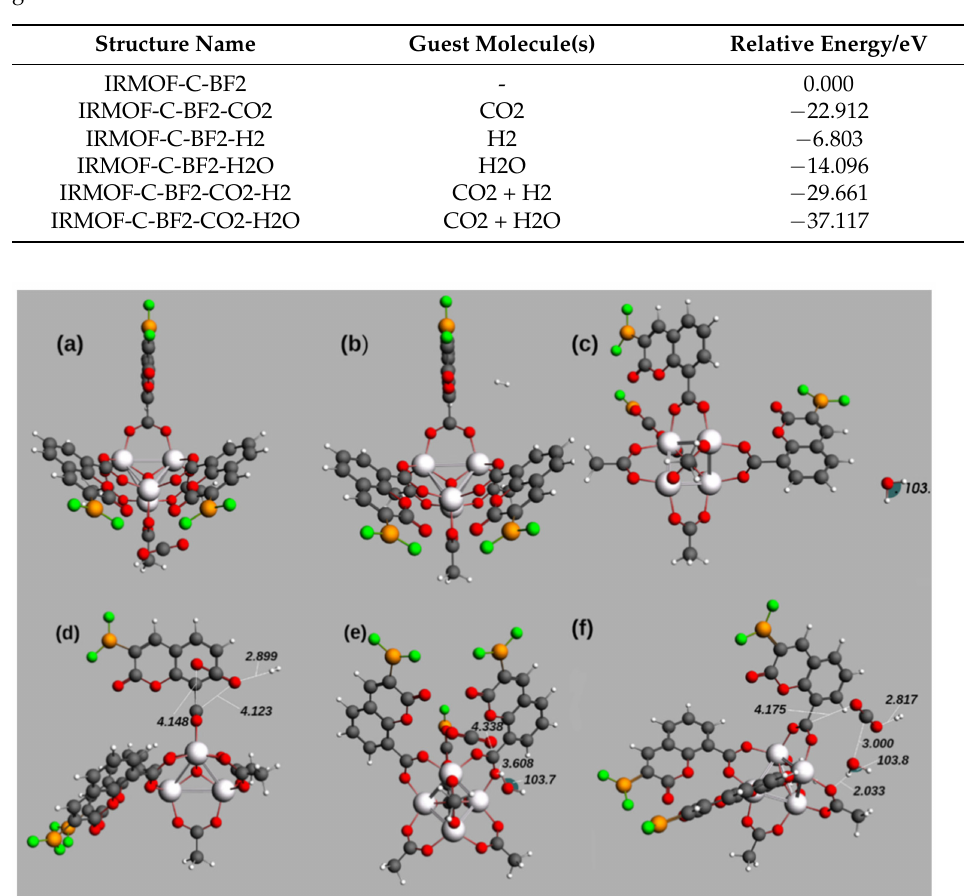
Table 4. Primitive cell’s bonding energies of IRMOF-C-BF 2 in the presence and absence of guest molecules.